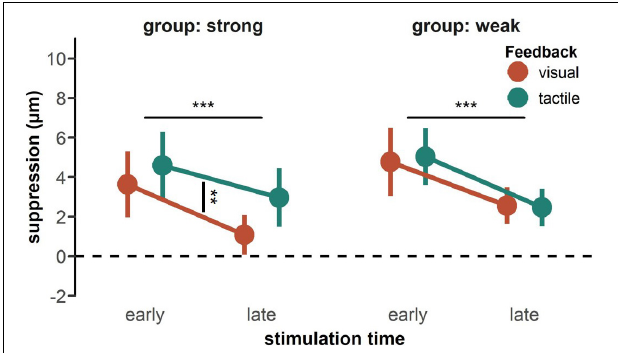
FIGURE 3 | Interaction of suppression scores by feedback type and feedback intensity. Data is plotted separately for both groups receiving a strong tactile feedback (left panel) and a weak tactile feedback (right panel) . Colored dots represent the mean across participants with error bars indicating the standard error of the mean. Only the group receiving strong tactile feedback showed a difference in suppression between feedback types. Statistics performed by a rm-ANOVA including feedback type (visual, tactile), stimulation time (early, late), and tactile feedback intensity (strong, weak), ** p < 0.01, *** p < 0.001.